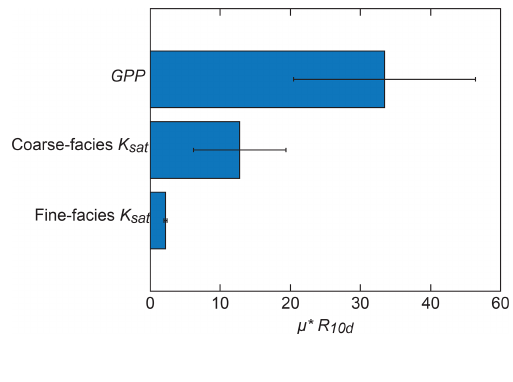
Figure 11. Morris µ ∗ value of R 10d for GPP and K sat of coarse- texture (gravel and sand) and fine-texture (muddy sand and mud) facies, where bars represent each µ ∗ estimate and whiskers repre- sent the respective 95% confidence interval of the